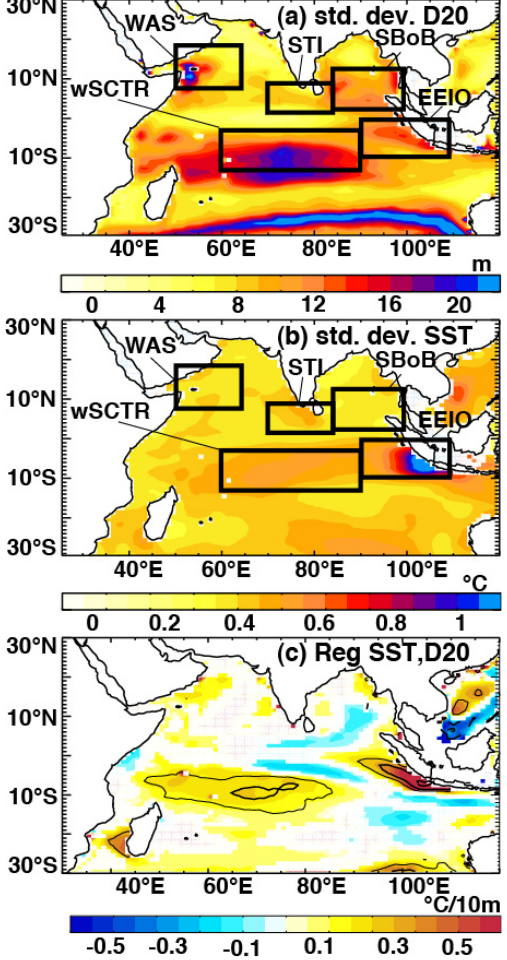
Fig. 3. Regional interannual variance of (a) D20 and (b) SST, as in- dicated by the standard deviation of their anomalies over the period 1961–2001. (c) Coefficients from a simple linear regression of SST and D20 anomalies over the same period, drawn only when beyond a 90% significance level. Thin and thick contours indicate corre- lation coefficients of 0.4 and 0.6 respectively, while solid (dashed) lines represent positive (negative) coefficients. Geographical boxes used in later analyses are shown in (a) and (b)